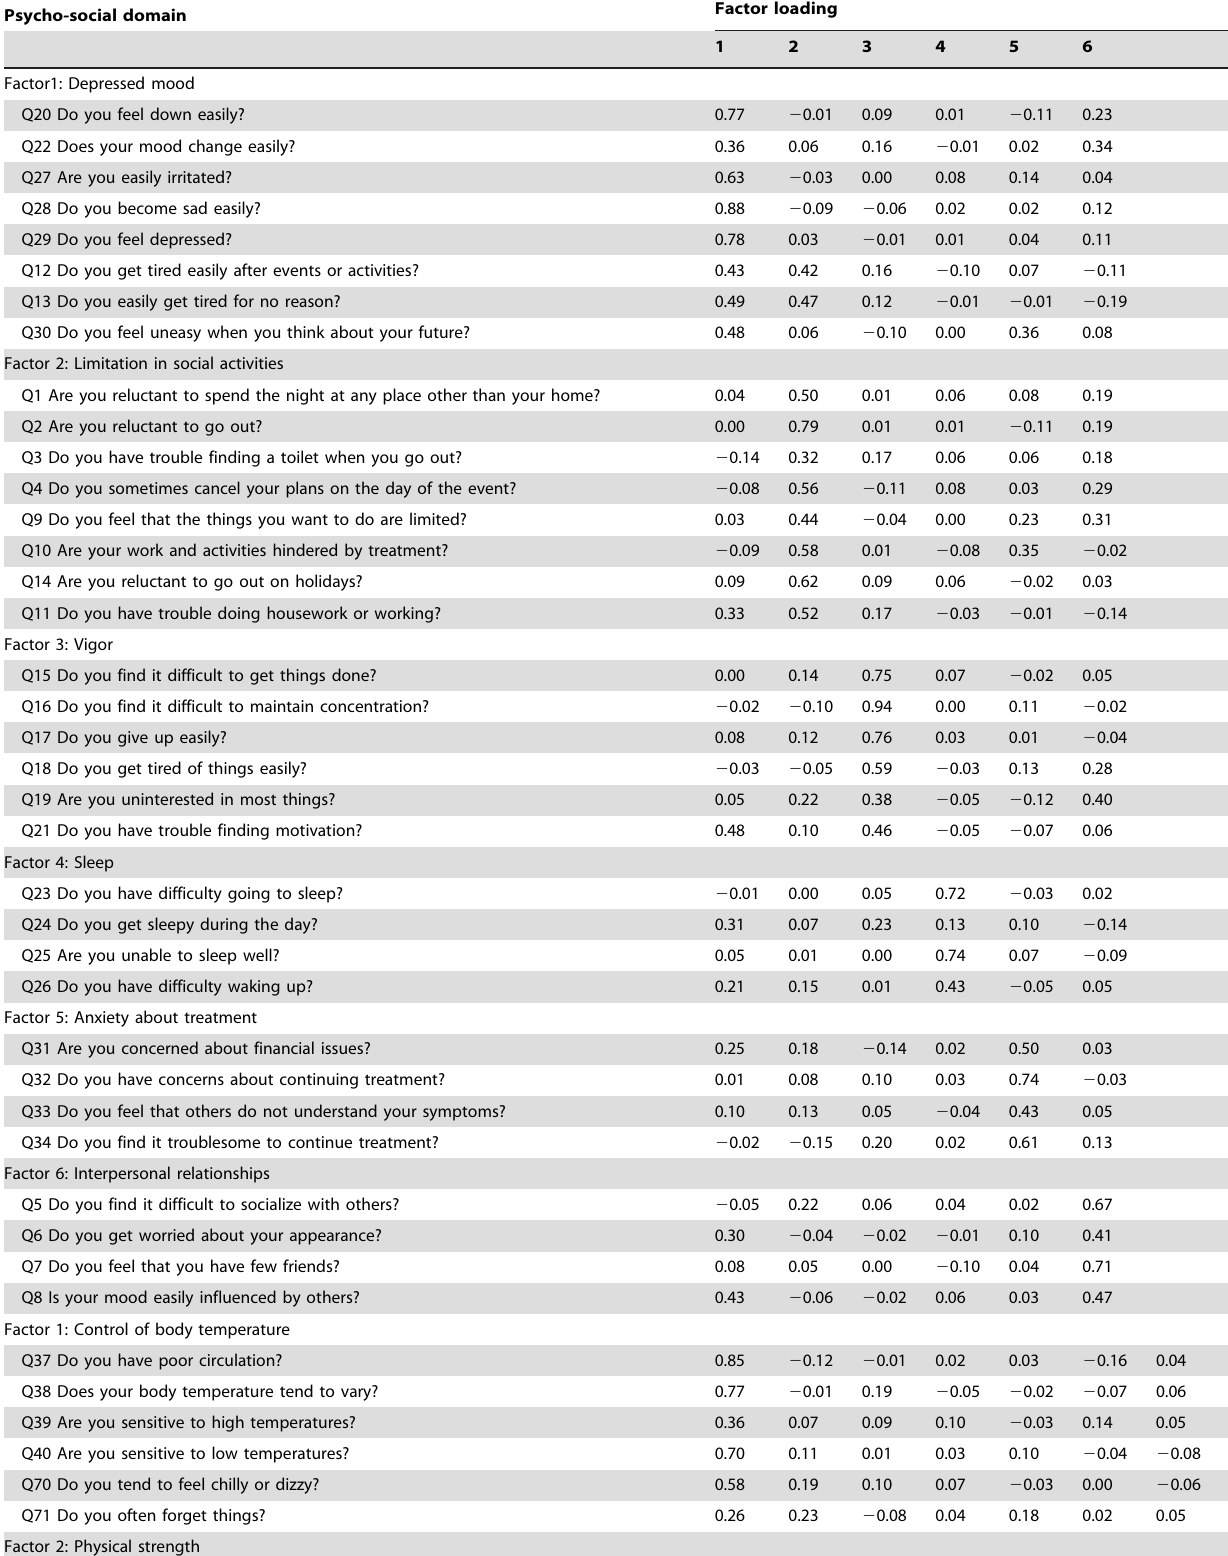
Table 2. Exploratory factor analysis